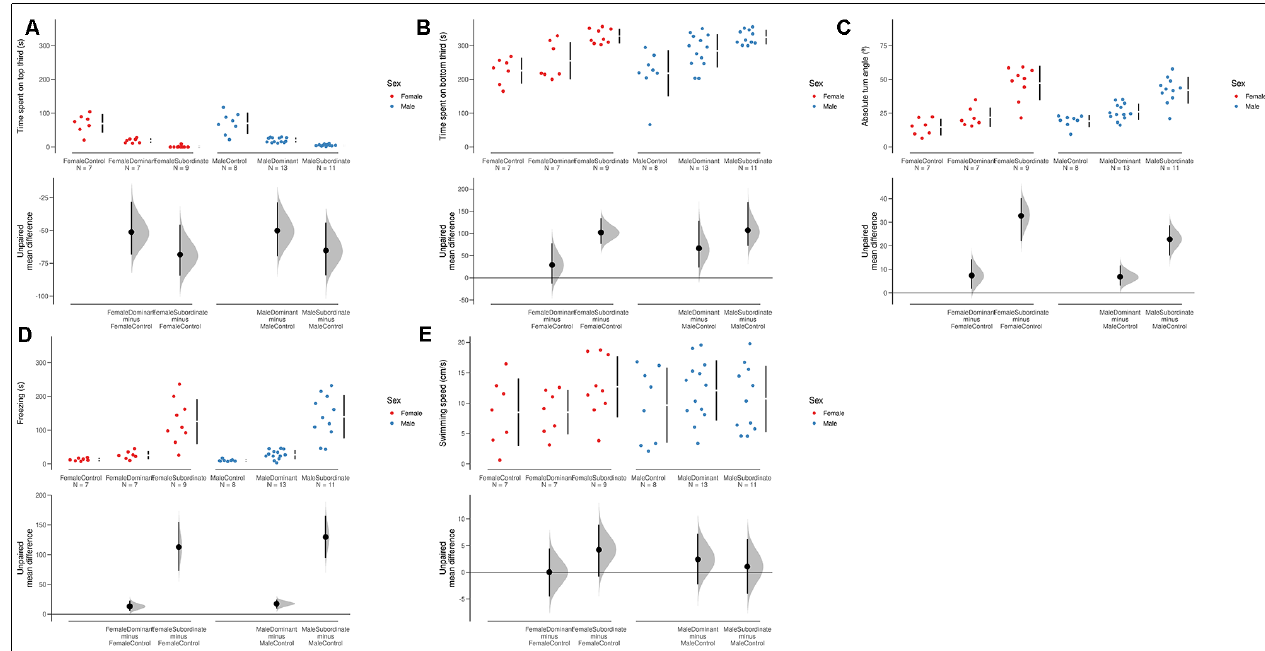
FIGURE 2 | Swarmplots and Cumming estimation plots for variables in the novel tank test. (A) Time spent at the bottom third of the tank. (B) Time spent at the top third of the tank. (C) Absolute turn angle. (D) Freezing duration. (E) Swimming speed. The mean difference for three comparisons against the shared control (male controls) in the above Cumming estimation plots. The raw data is plotted on the upper axes. On the lower axes, mean differences are plotted as bootstrap sampling distributions. Each mean difference is depicted as a dot. Each 95% confidence interval is indicated by the ends of the vertical error bars. 5,000 bootstrap samples were taken; the confidence interval is bias-corrected and